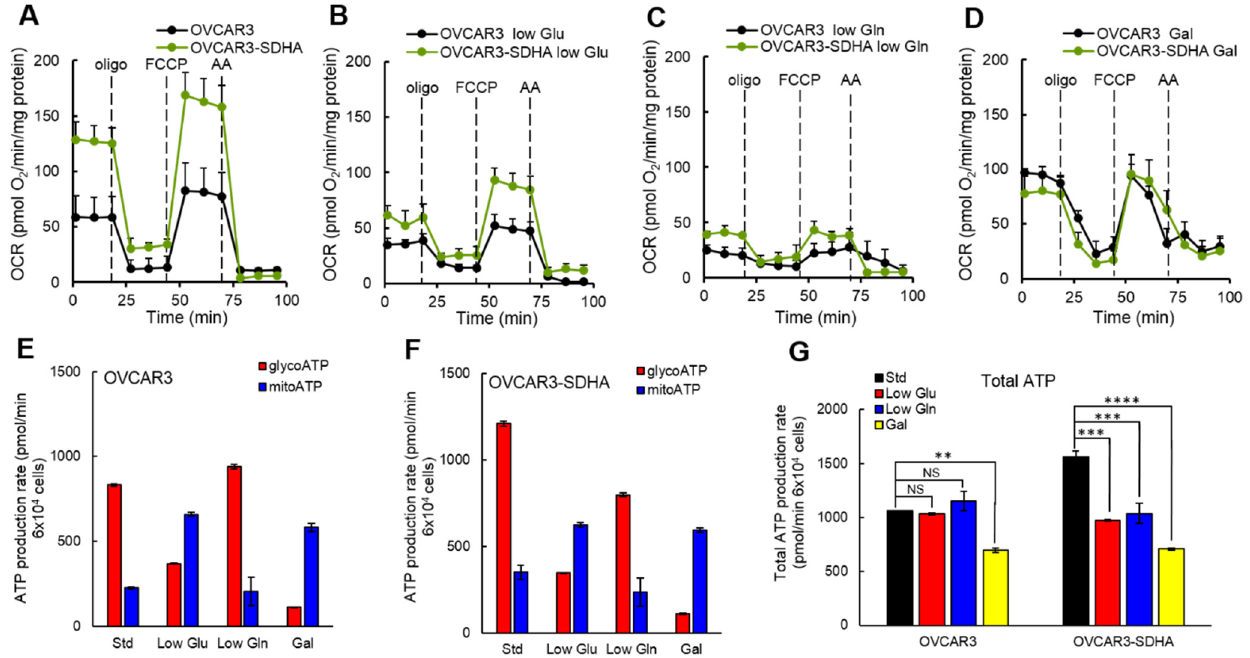
Figure 7. The effect of nutrient deprivation on cellular energetics of ovarian cancer cell lines over- expressing SDHA. ( A ) OCR was measured in OVCAR3 +/ − SDHA cell lines in complete medium. SDHA overexpression led to a significant increase in basal, maximal and reserve respiration. ( B ) In low glucose (Glu) medium, the OCR was suppressed in both cell lines, when compared to OCR in complete medium. ( C ) In low glutamine (Gln) medium, the OCR was suppressed the strongest in both cell lines. ( D ) In galactose (Gal) medium, the basal respiration was higher than the basal respira- tion in low Glu or Gln medium reflecting an increased reliance on OXPHOS in cells with substantially inhibited glycolysis. ( E , F ) Quantitative measure of an ATP production rate from mitochondrial OXPHOS (mitoATP) or glycolysis (glycoATP) in various nutrient deprivation conditions in OVCAR3 ( E ) and OVCAR3-SDHA ( F ) cell lines. ( G ) Total ATP production rate in OVCAR3 cell lines exposed to nutrient deprivation. Data are represented as mean ± SEM (unpaired t -test, **** = p < 0.0001, *** = p < 0.001** = p < 0.01, NS = not significant).